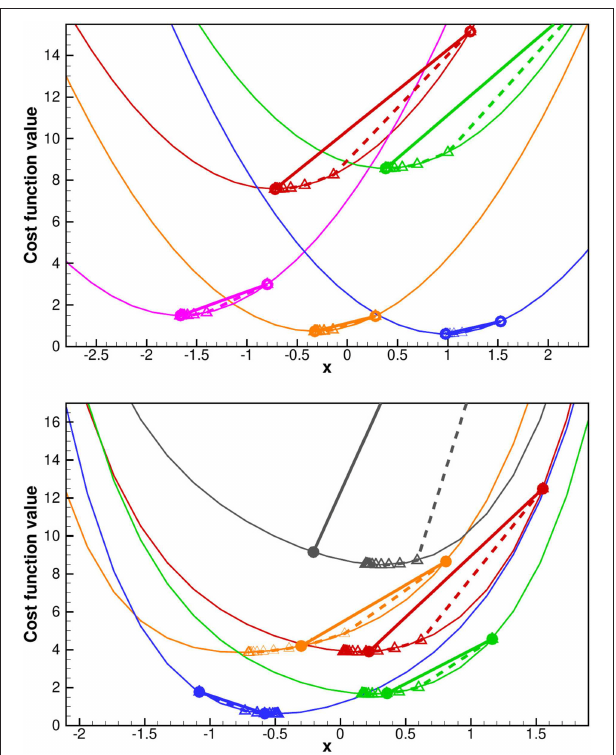
FIGURE 1 | Examples of IES cost functions in the linear (upper plot) and non-linear (lower plot) cases. The full straight lines are the ES updates from the prior value to the estimated solution for each realization. The dashed lines show the IES steps. The ES and IES solutions are identical in the linear case and finds the global minimum. In the non-linear case IES gives an approximate estimate for the minimum that outperforms ES.